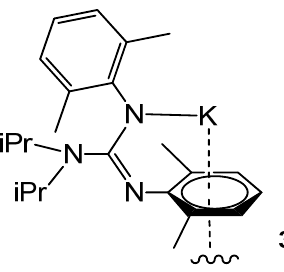
Figure 4. Polymeric potassium compound through η 6 -arene interactions.